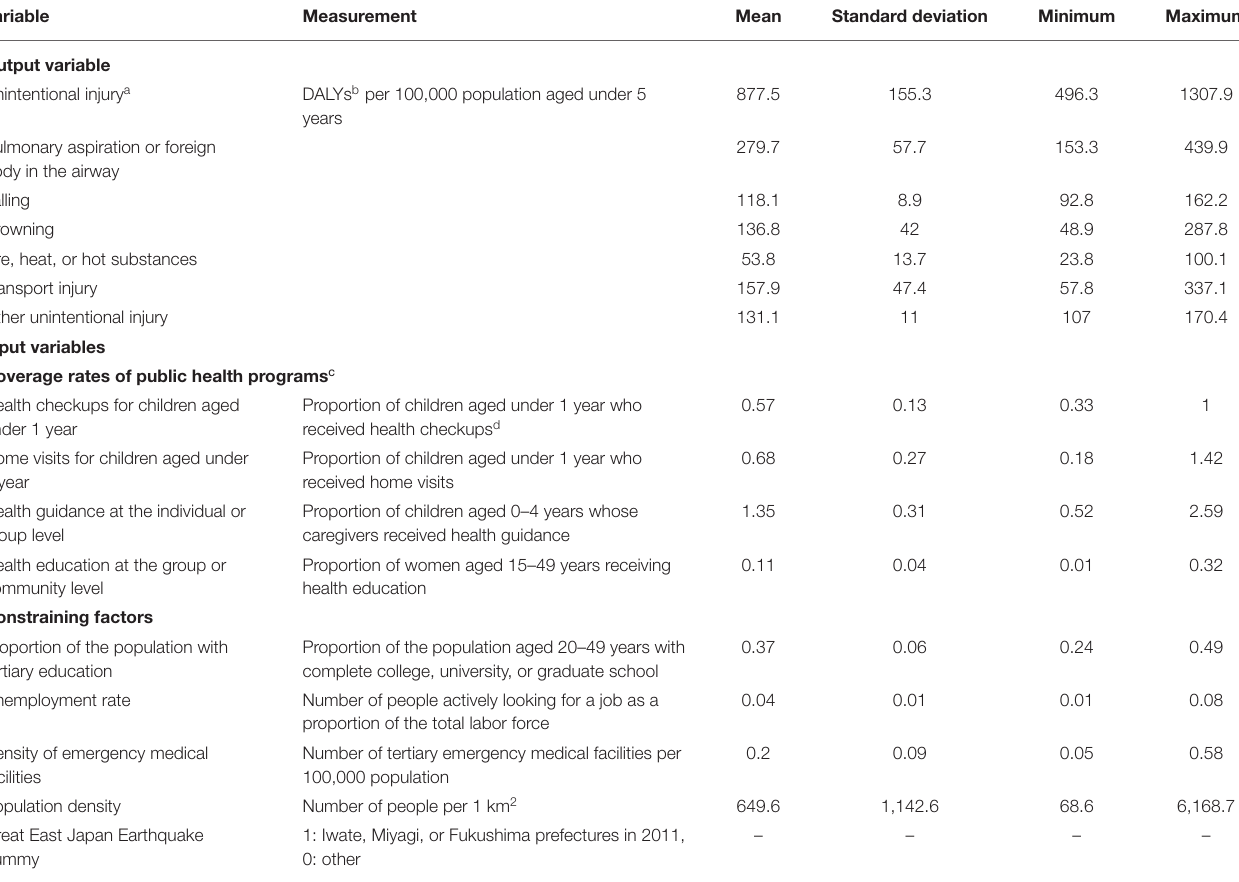
TABLE 1 | Descriptive statistics of output, input, and constraining factors from 2001 to 2017 ( n =